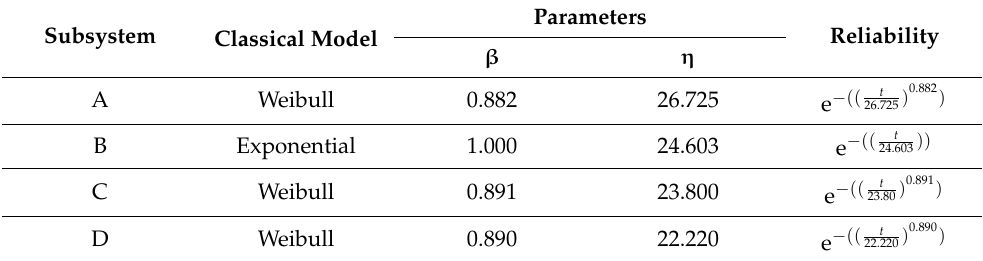
Table 8. The parameter estimation of the classical model.